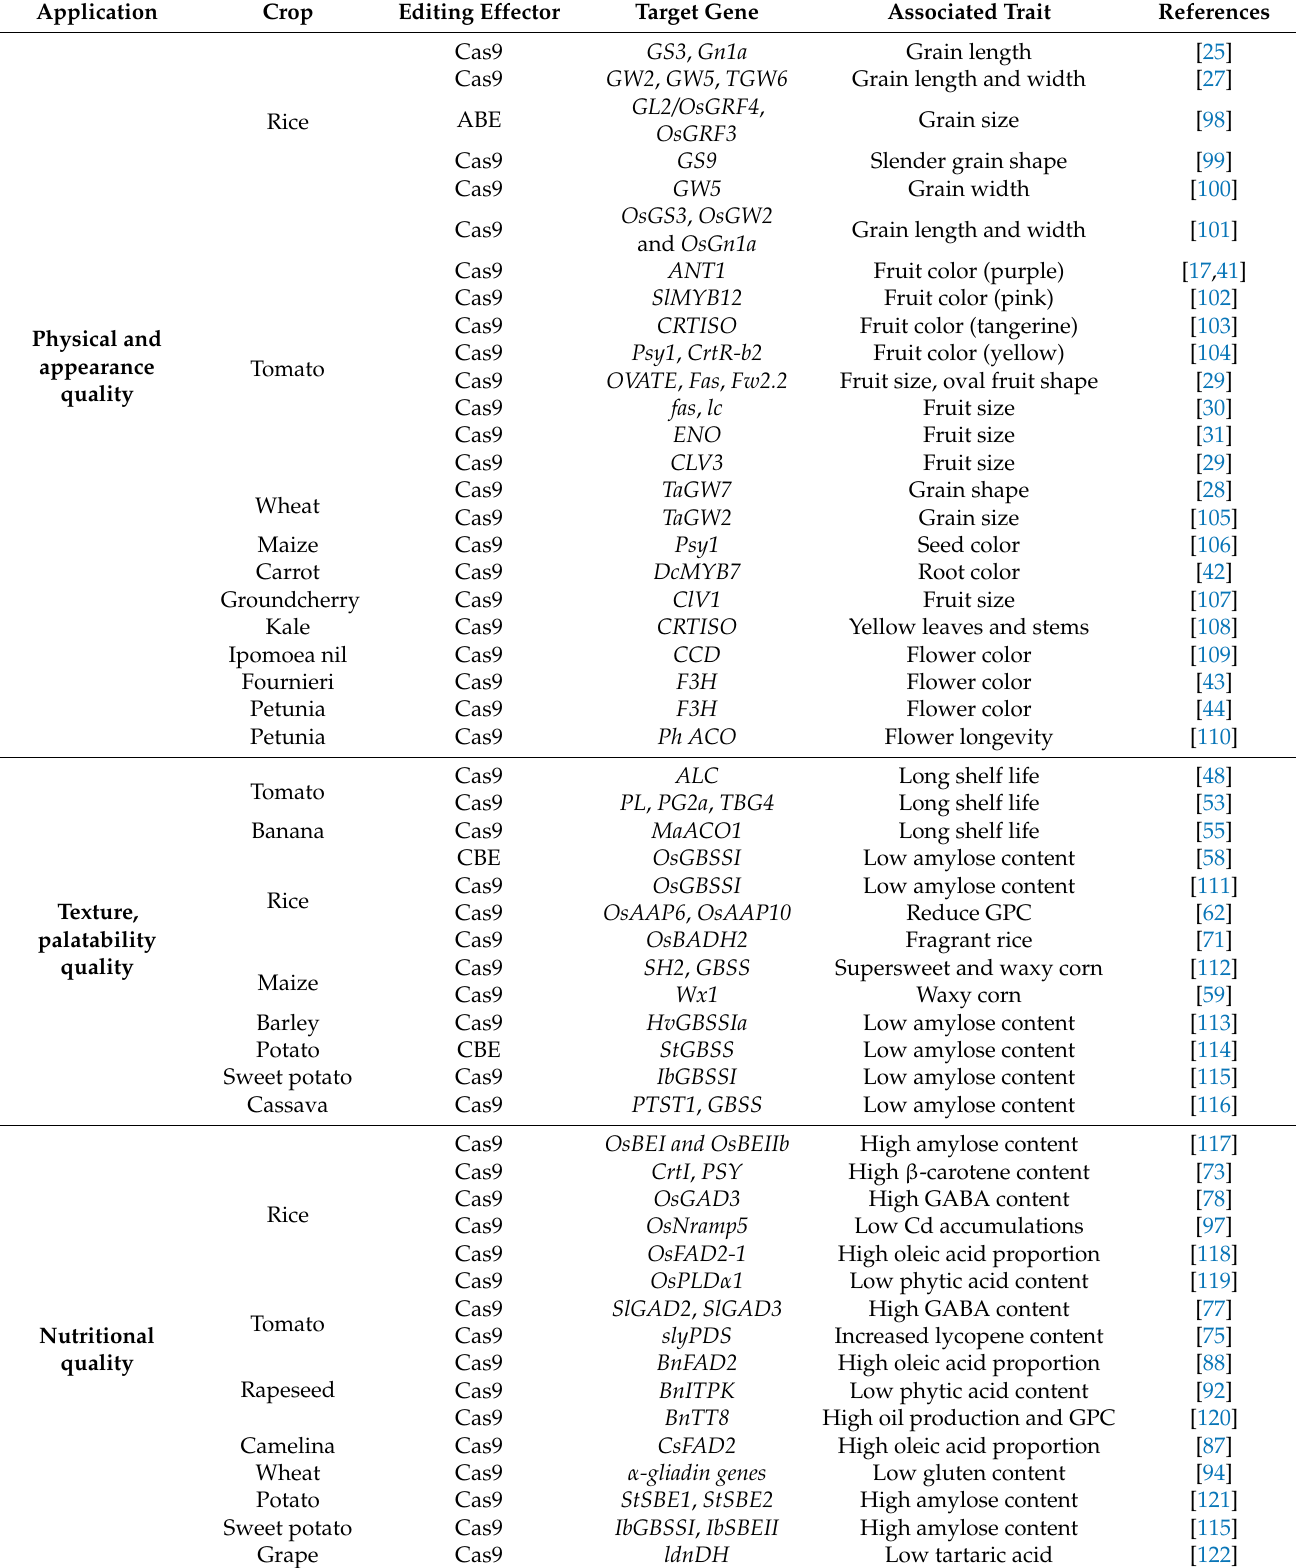
Table 2. List of research on crop quality improvement by using CRISPR/Cas gene-editing